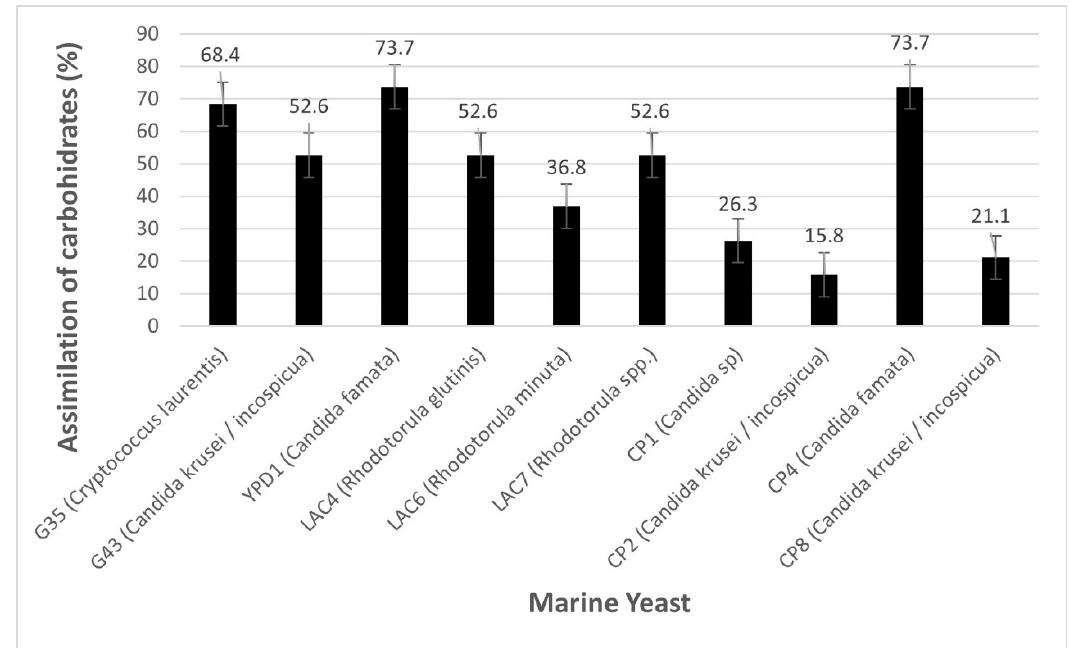
Figure 2. Percentage of assimilation of all carbohydrates by